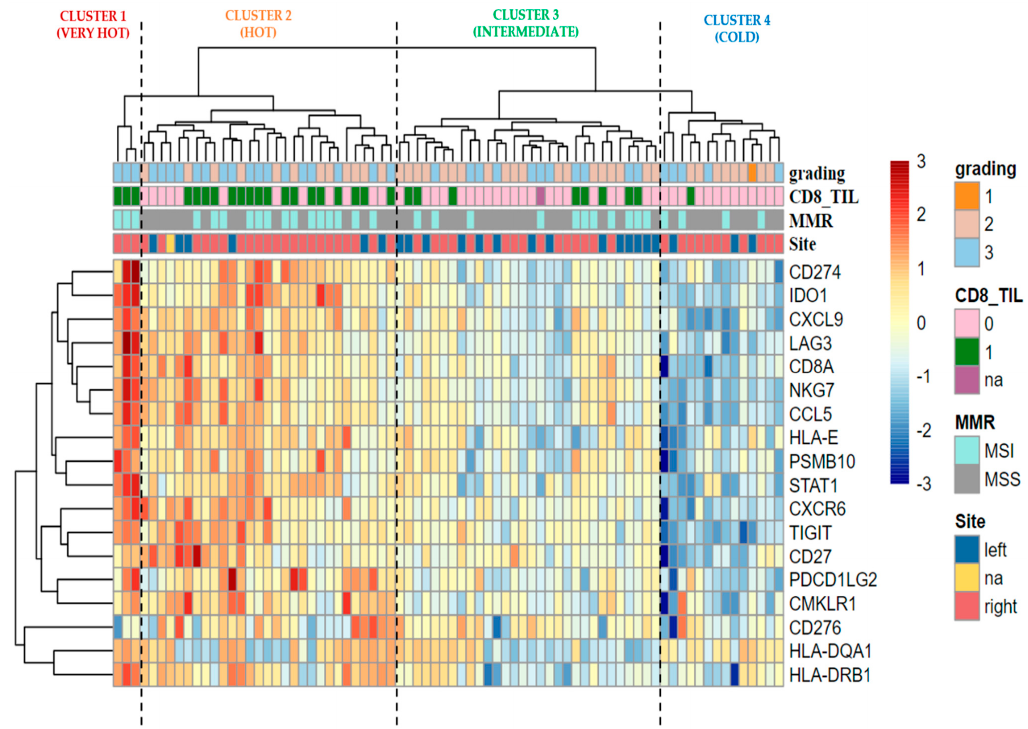
Figure 5. The ‘TIS’ heatmap uses unsupervised hierarchical clustering to show relatedness among the 18 genes in TIS for each sample. Z-scores are calculated based on each gene to have a mean of zero and a standard deviation of one. The standardized signature scores are truncated at ±3 standard deviations to preserve greater clarity in color change within the largest proportion of data (99% of the data should fall within ±3 standard deviations of the mean). Sample annotations are listed at the top of the heatmap: grading; CD8 positive (category 1) vs. CD8 negative (category 0) CRCs (pink vs. green); MSI vs. MSS tumors (aquamarine vs. grey); anatomical site of onset left vs. right (blue vs. red). Na, not available data; MMR, mismatch repair status; MSI, microsatellite unstable; MSS, microsatellite stable.